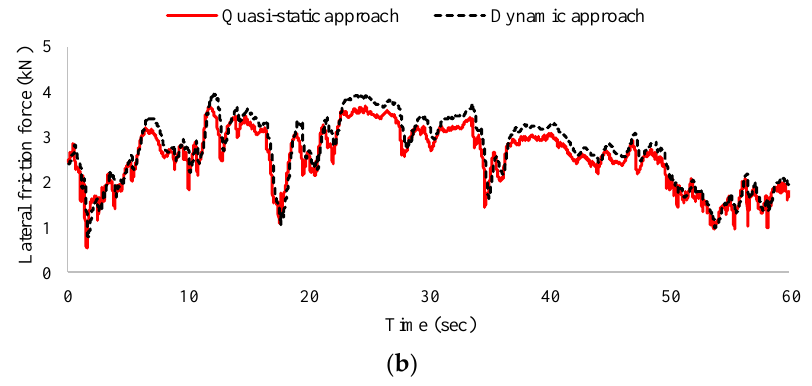
Figure 12. Time histories of tire forces of front axle of the van: ( a ) vertical and ( b ) lateral force.